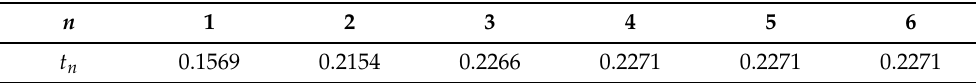
Table 2. Sequence (6) for Example